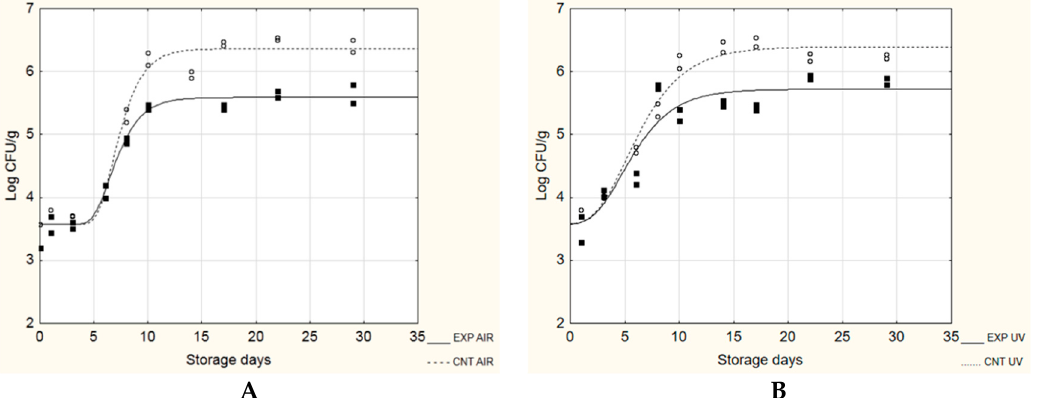
Figure 3. Evolution of Ps. fluorescens during the challenge test at 4 °C. EXP, cheeses stored with probiotic biofilms; CNT, cheeses stored without probiotic biofilm. ( A ), AIR packaging; ( B ), under vacuum packaging (UV).